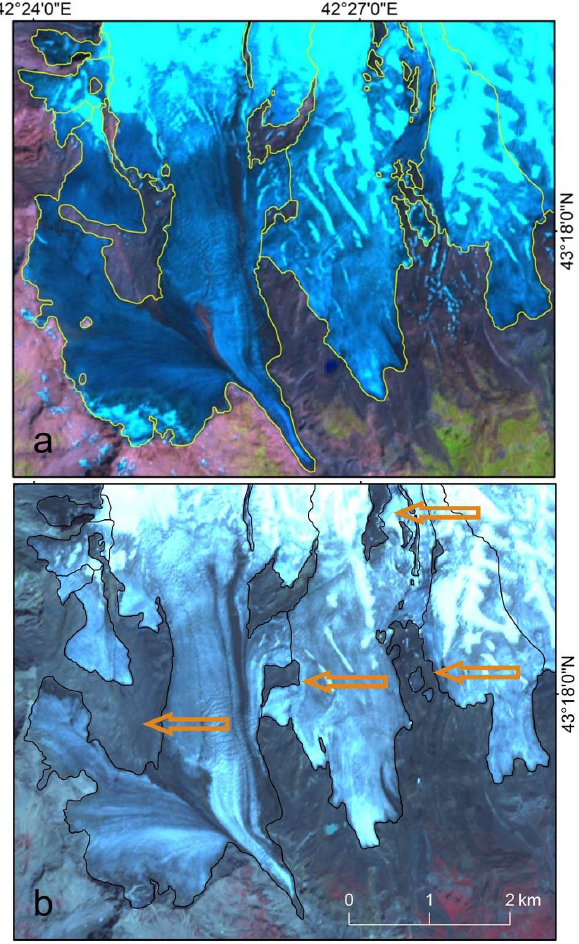
Figure 5. Expansion of exposed rocks on the southern slope of Mt. Elbrus: (a) 1999 and (b) 2012. Arrows point at the expanded areas of exposed rocks. The 1999 Landsat ETM + image (Table 1) is used as background.